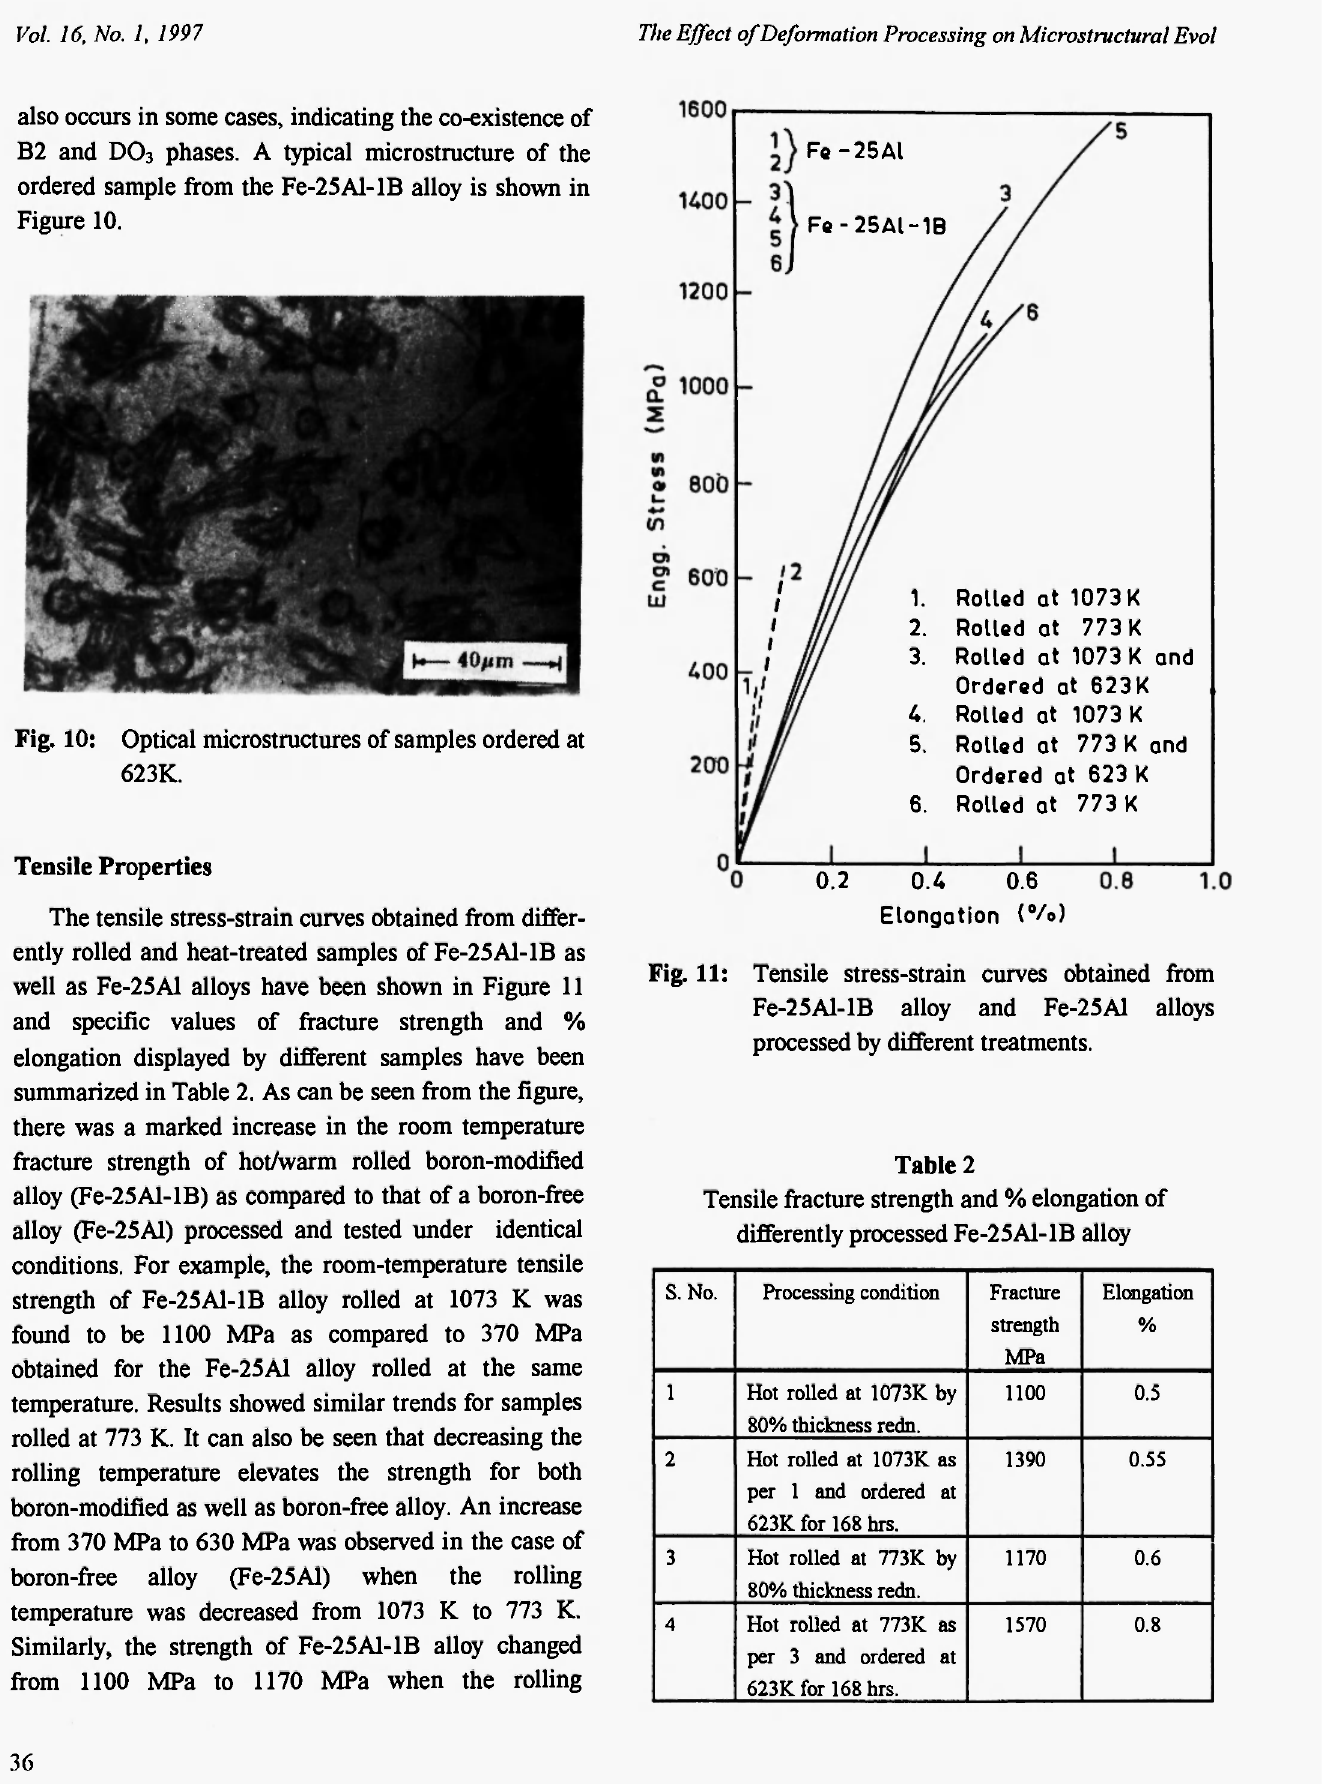
Fig. 10: Optical microstructures of samples ordered at 623K.